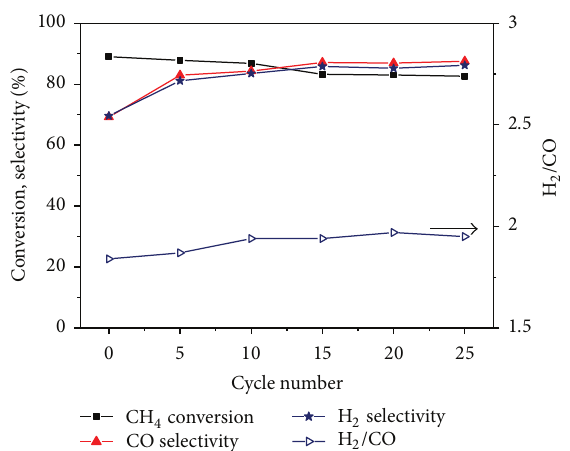
Figure3:Theeffectofredoxcyclenumberontheselectiveoxidation of methane using Ce 0.7 Fe 0.3 O 2 oxygen carrier at 850 ∘ C [36].